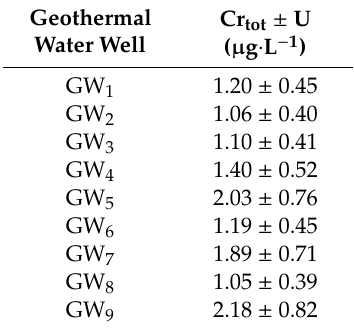
concentration of chromium standard solution was 10 µg ∙ L − 1 . The results of recovery were obtained by comparison of spiked and unspiked samples for all geothermal water intakes. Calculated values